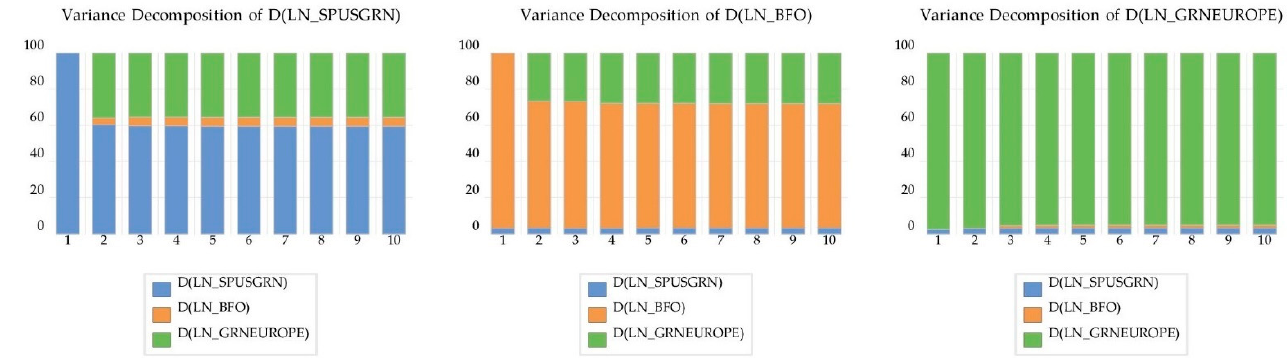
Figure A5. Variance decompositions in model 2 using Cholesky factors.